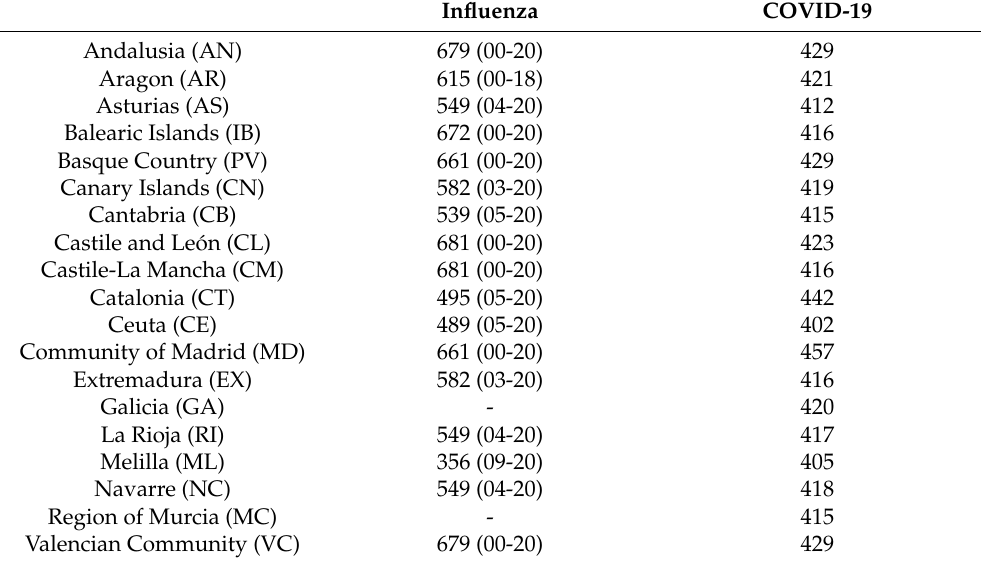
Table A1. Length (number of data points) of each series. It spans from early 2000s to the